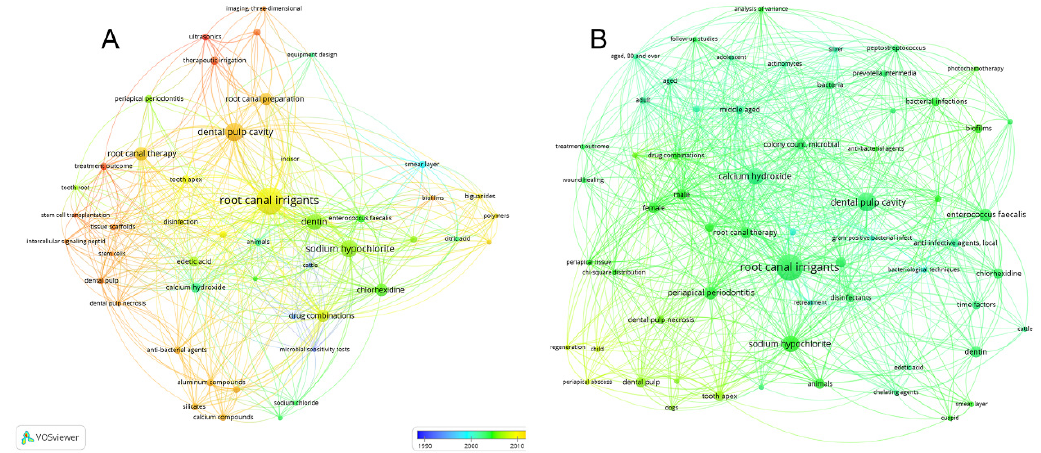
Figure 5. Visualization of Mesh keywords of the highest RCRs and top-cited from the 24 articles not common to both lists having two or more occurrences in the period 1990–2019. The red and orange colors represent the most recent keywords near 2019, while blue and violet zones show the oldest keywords. ( A ). The top 24 RCRs articles: 48 nodes, 5 clusters, and 800 lines. Predominance of green, yellow and orange colors. ( B ). The top 24 cited articles: 62 nodes, 4 clusters, and 800 lines. Predominance of green color.